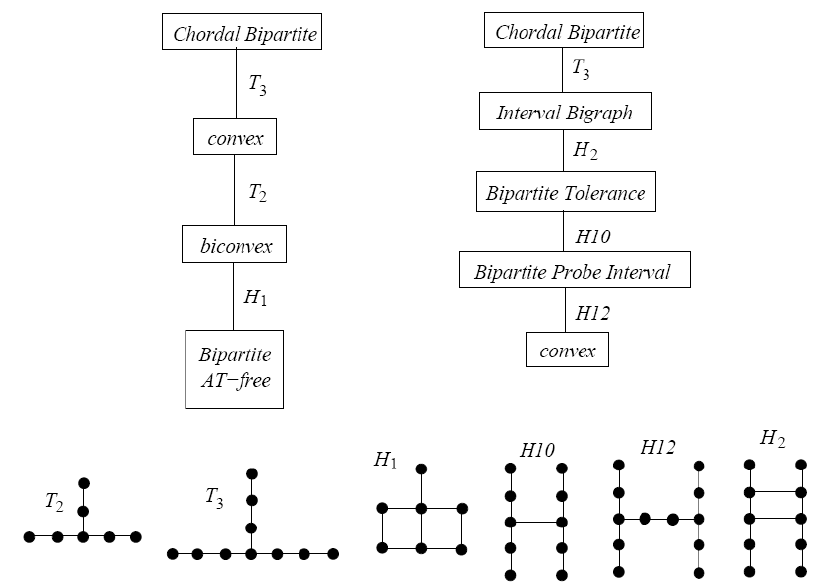
Fig. 1: Hierarchy of Chordal Bipartite graphs with separating